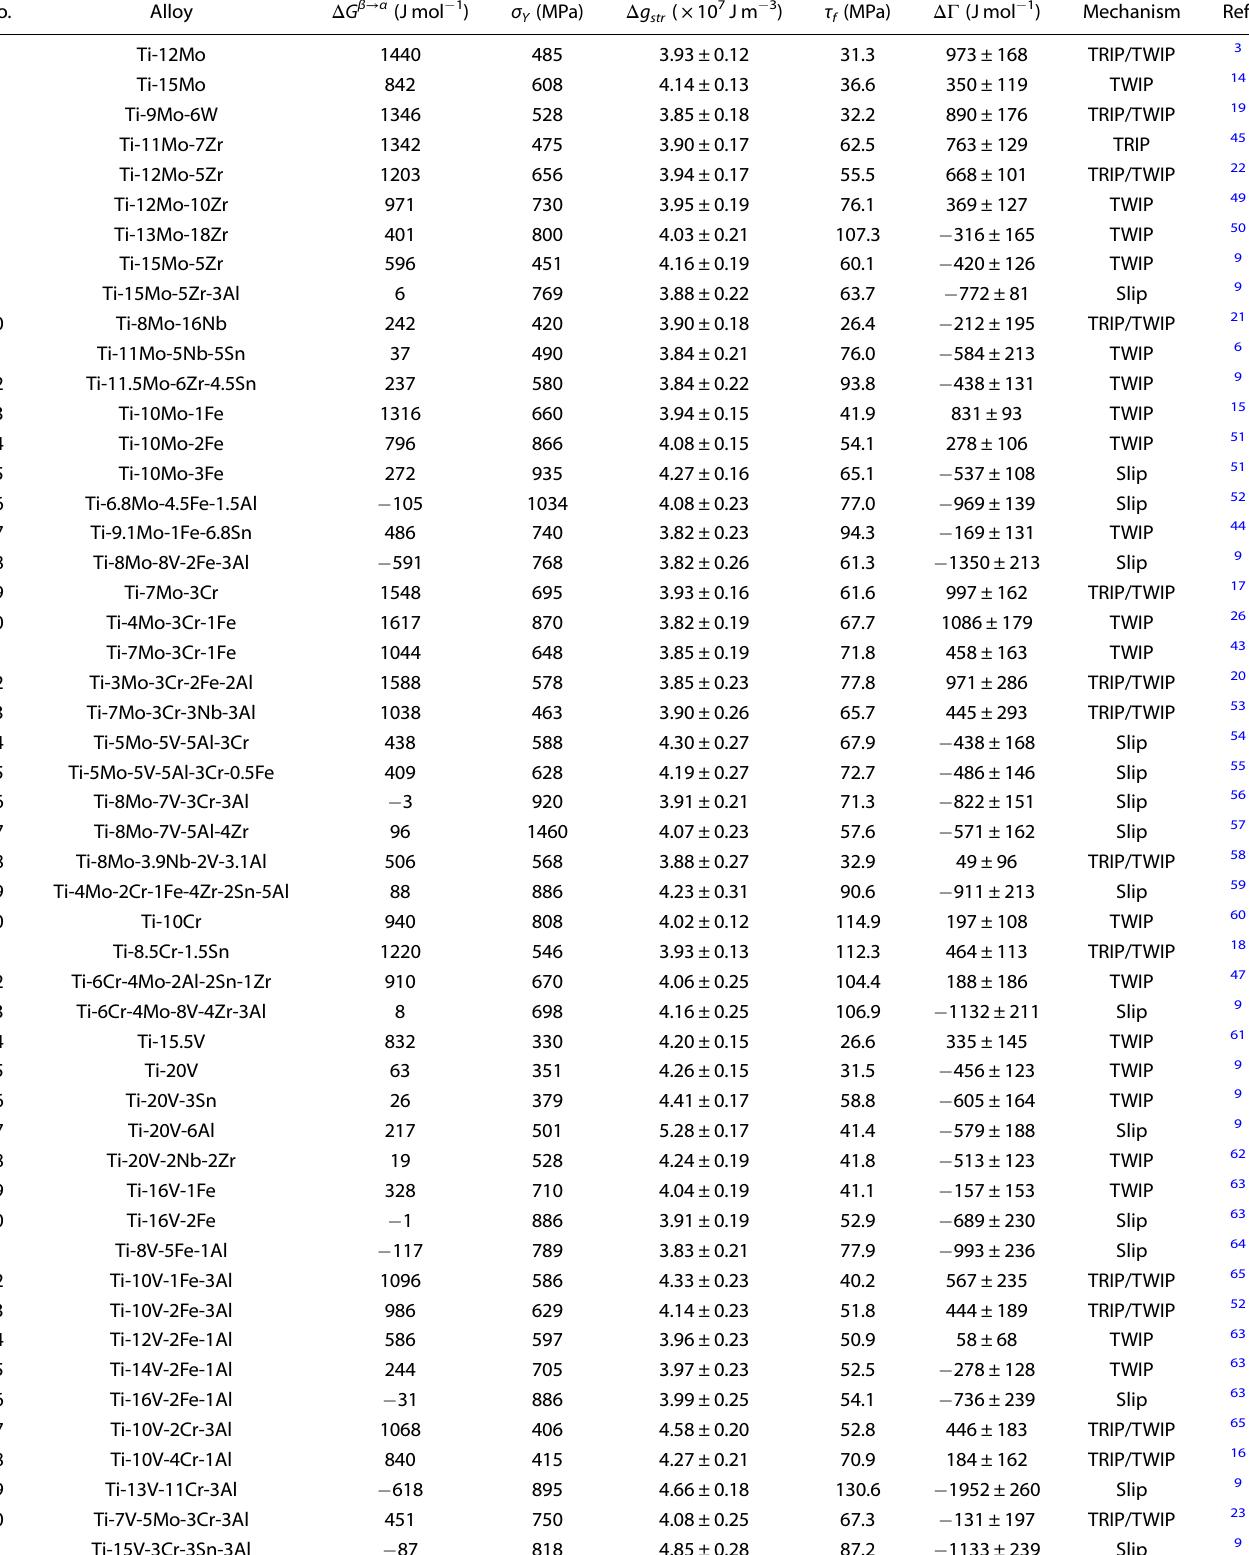
Table 3. β -Ti alloy dataset including alloy compositions, Gibbs free energy change Δ G β → α , elastic strain energy Δ g str , yield stress σ Y , frictional shear stress τ f and the energy landscape parameter ΔΓ